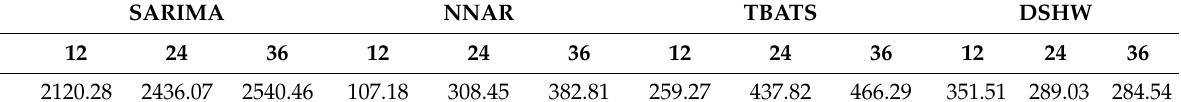
Table 9. RMSEs of ℎ -step ahead forecast for the hourly electricity load of Poland obtained by SARIMA, NNAR, TBATS, and DSHW models.